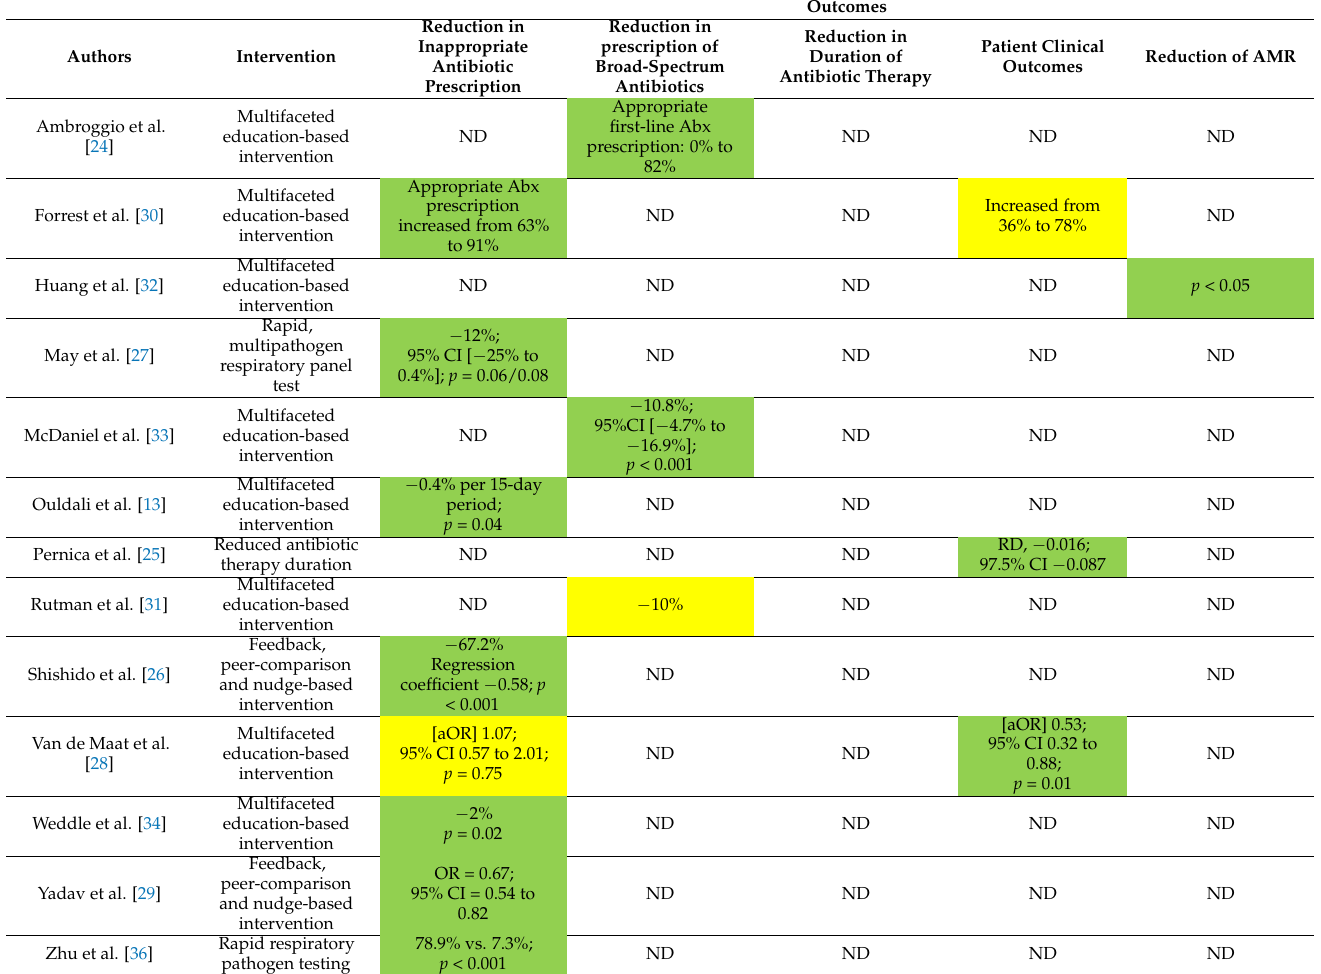
Green—reduction with statistical significance; Yellow—reduction withoyt statistical significance; ND—not